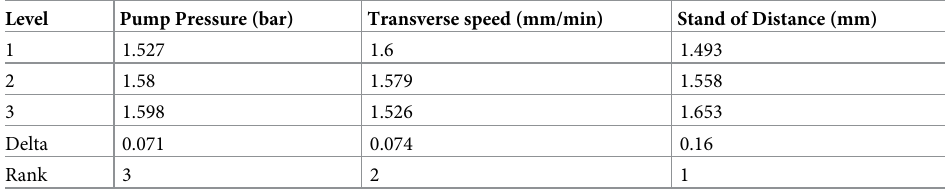
Table 7. Response table of 0.2 wt. % reduced graphene oxide loaded